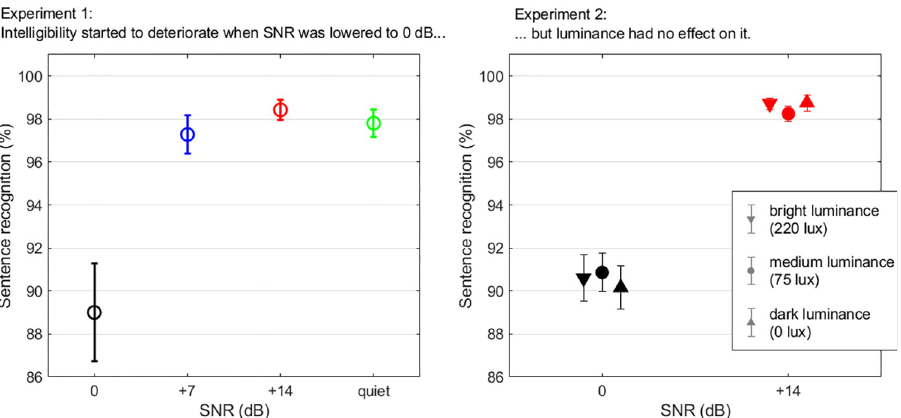
Fig 1. Performance in the sentence recognition task. Lists of twenty sentences presented at different SNRs in Exp.1 (left panel), in which 21 listeners sat in a normally-lit room (75 lux). Exp.2 measured performance in the same task (using different sentence lists than in Exp.1) at two SNRs in which 28 listeners sat in the same room under similar luminance settings (75 lux), or in close-to-darkness (0 lux), or in very bright luminance settings (220 lux). Luminance (although it has a huge impact on the pupil) had no effect on behavioral performance. Error bar represents 1 standard error from the mean.